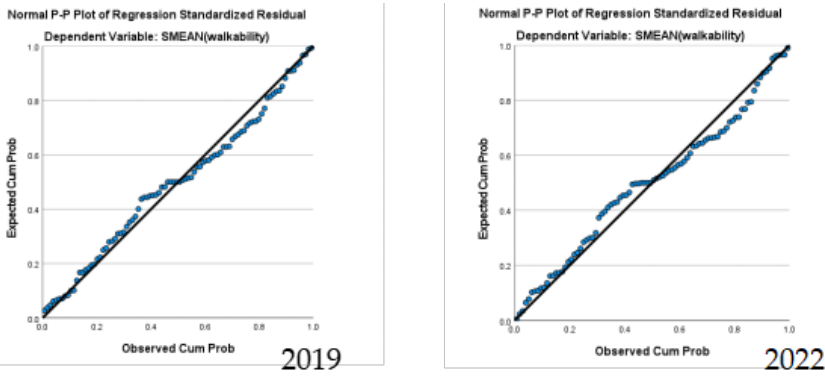
Figure 11. Normal probability plots.